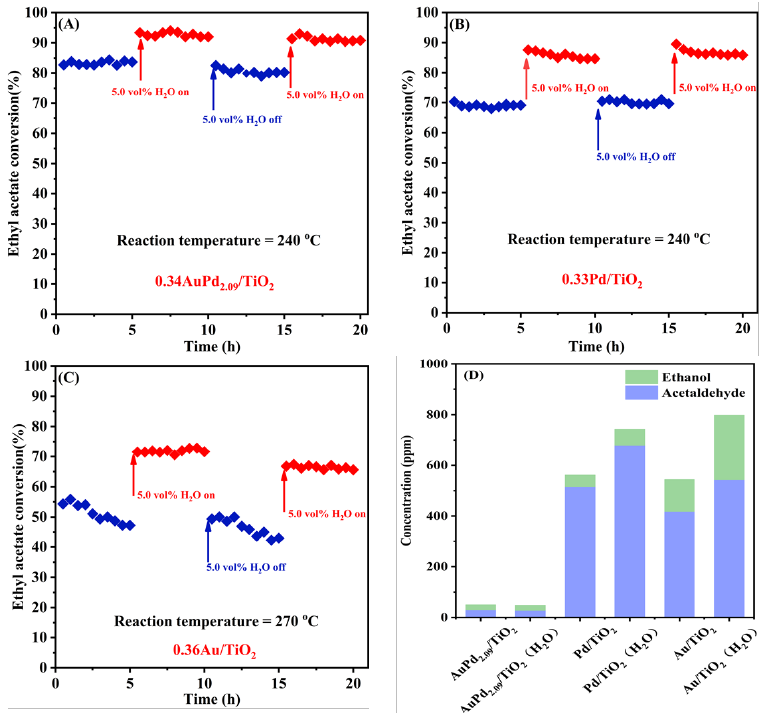
Figure 7. Effect of 5.0 vol% water vapor on ( A–C ) catalytic activity and ( D ) intermediate selectivity of the ( A ) 0.34AuPd 2.09 /TiO 2 , ( B ) 0.33Pd/TiO 2 , and ( C ) 0.36Au/TiO 2 samples for ethyl acetate oxidation at an SV of 40,000 mL/(g h).